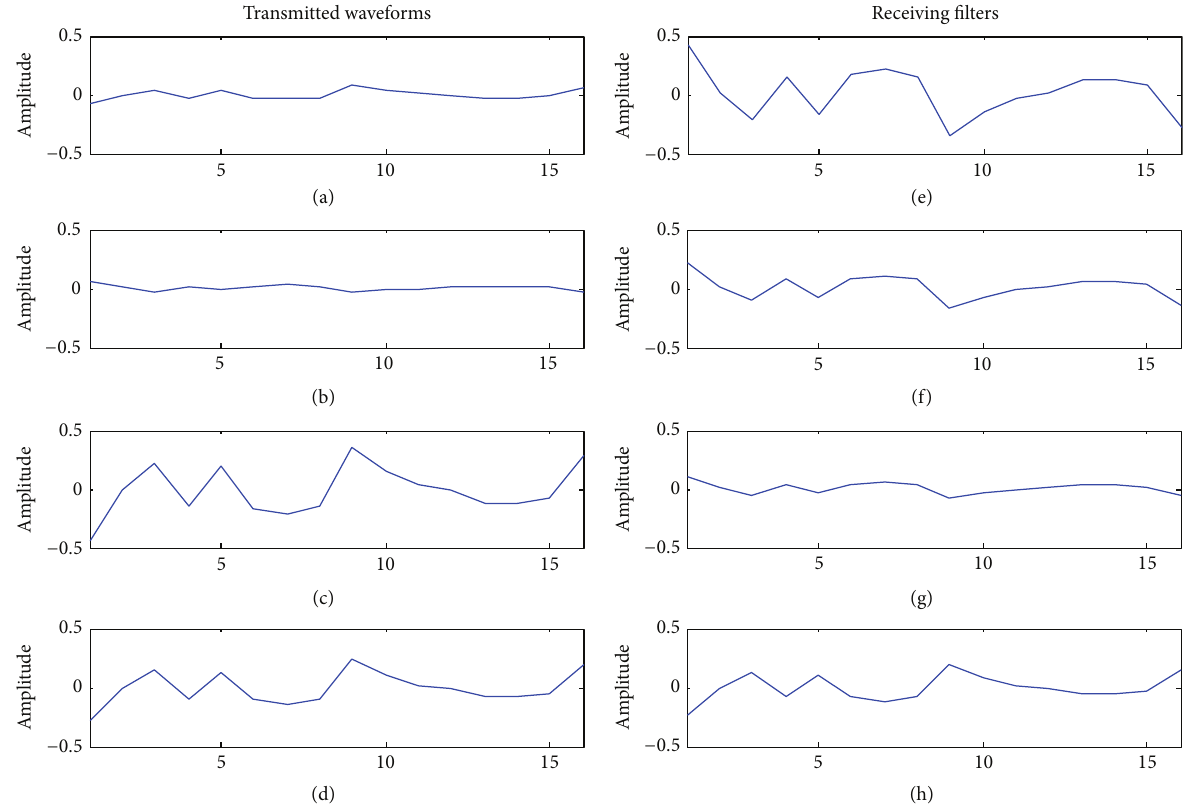
Figure 5: The optimized results: (a)–(d) are transmitted waveforms and (e)–(f) are receiving filters.